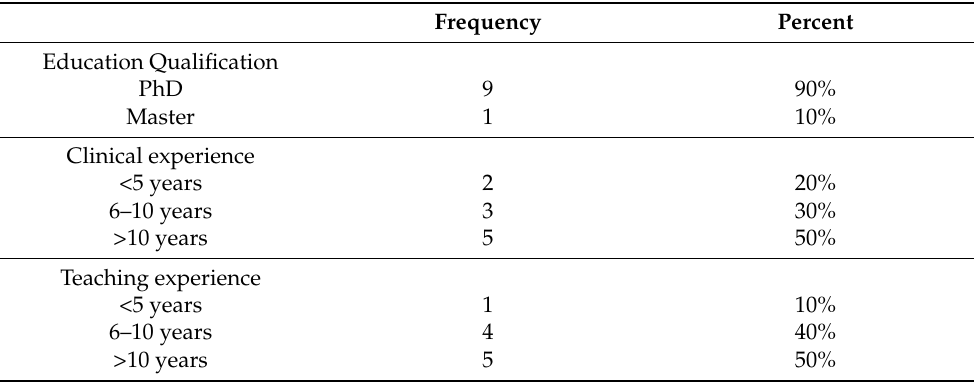
Table 1. Sociodemographic Data of the Study